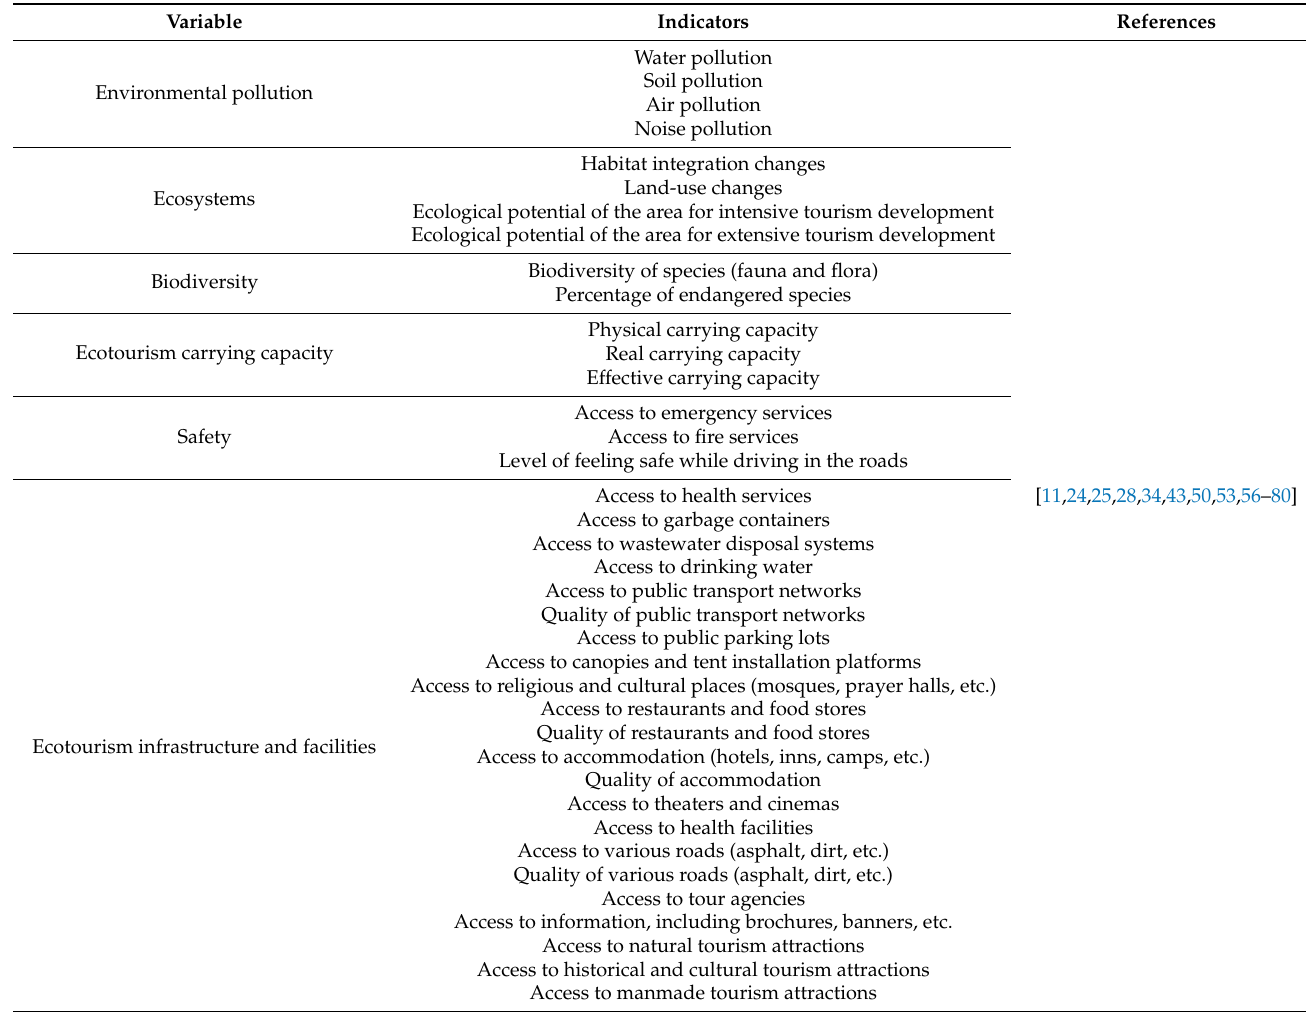
Table 2. Sustainable ecotourism indicators in the environmental–physical dimension.